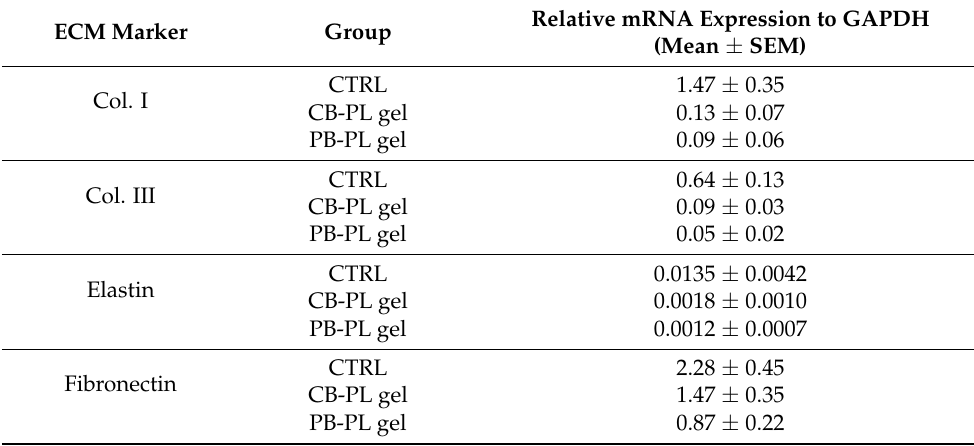
Figure 5. The relative mRNA expression of ECM markers, including ( a ) collagen-I, ( b ) collagen-III, ( c ) elastin, and ( d ) fibronectin, was analyzed among PL gels and CTRL on day 3. The results were based on six independent tests ( n = 6) and the means ± SEM were reported. The statistical significance of CB-PL gel and PB-PL gel in comparison to CTRL was indicated by * p < 0.05. Table 1. Relative mRNA expression of ECM markers during wound healing.